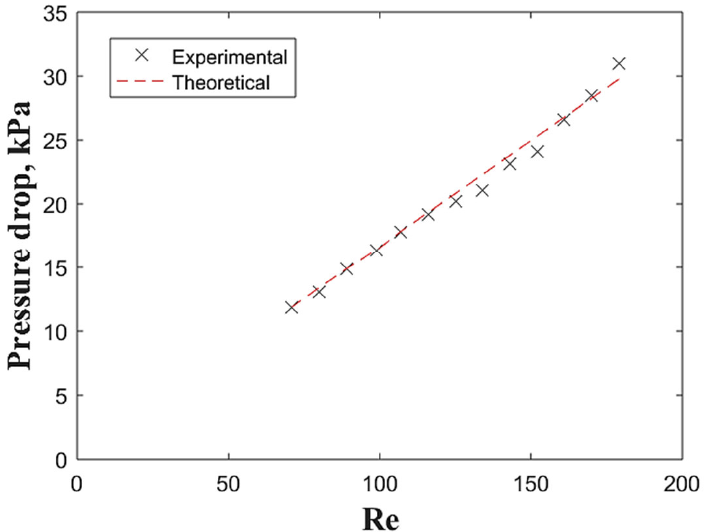
Figure 10. The variation of the PDV of the microchannel with Reynolds number for microchannel with a channel dimension of 0.2 mm × 0.2 mm.